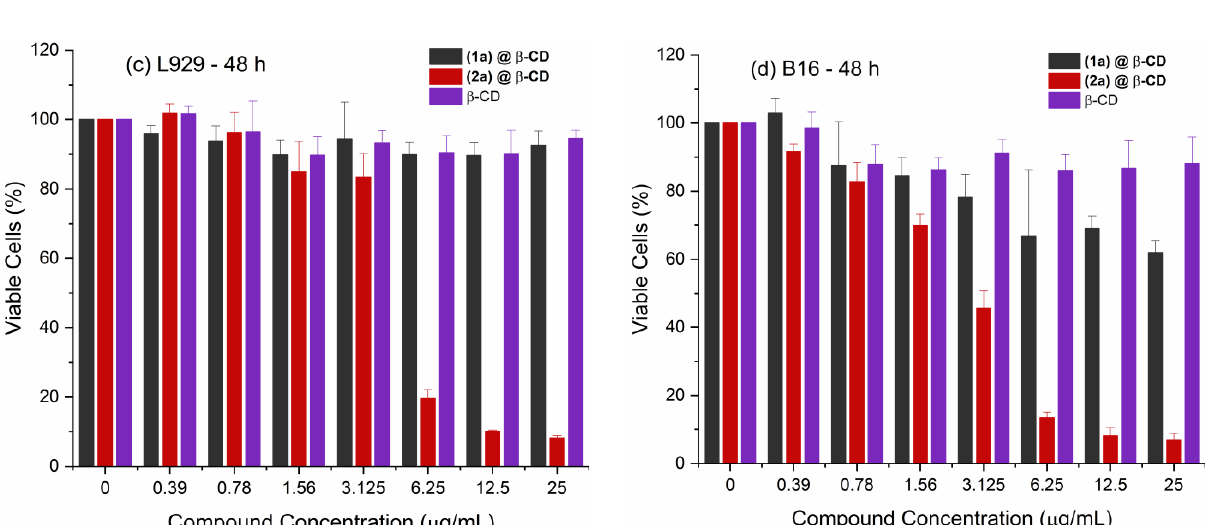
Figure 12. Cell viability of L929 cells treated for 24 h ( a ) and 48 h ( c ), and B16 cells treated for 24 h ( b ) and 48 h ( d ) with increasing concentrations of the three compounds ( p values are based on ANOVA analysis with Dunnett’s multiple comparisons post-test versus control condition).